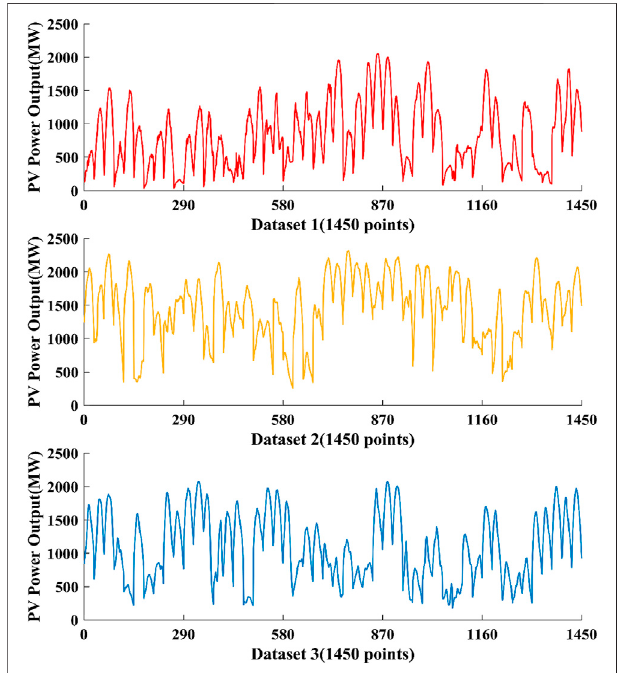
FIGURE 2 | Original PV power output time series in these studied